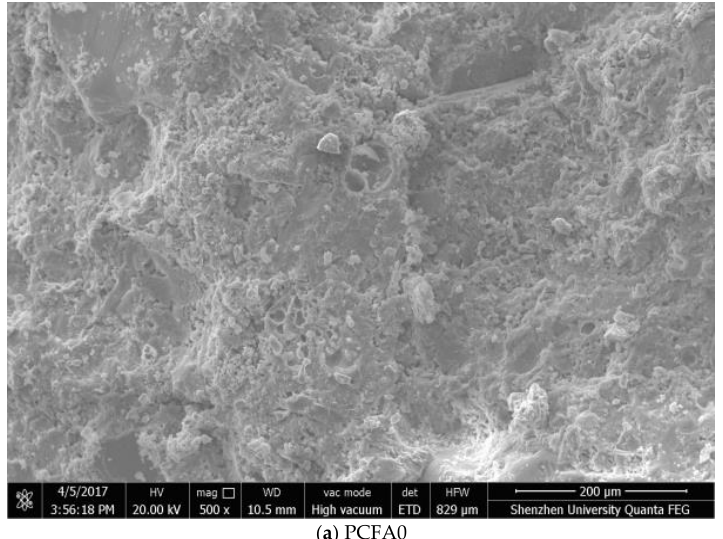
Figure 11. Pore size distribution of concrete with different fly ash additions after 90 days of curing.